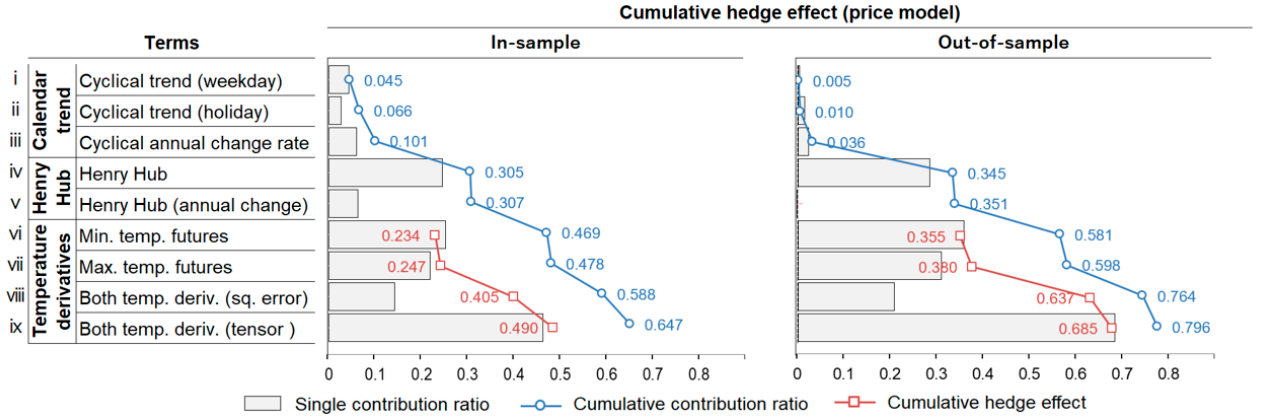
Figure 10. Contribution ratio and hedge effect of price model.